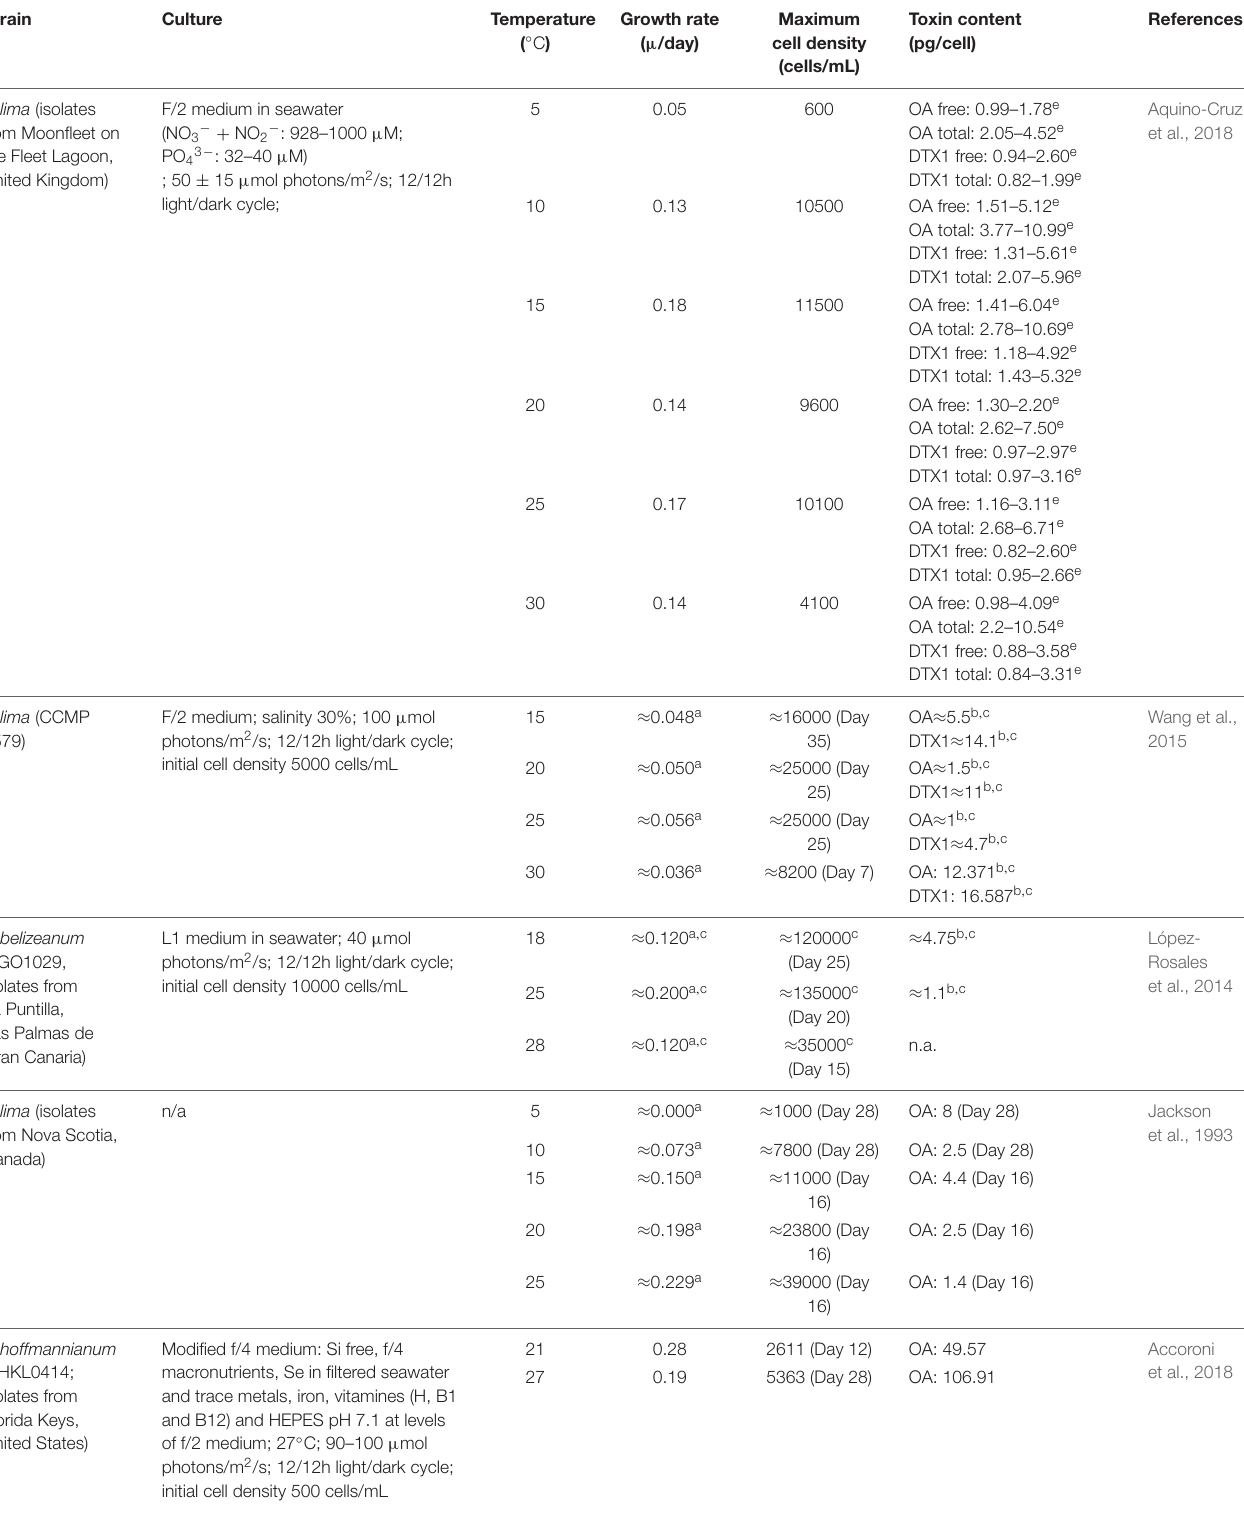
TABLE 5 | Effect of temperature on the growth and toxin content of Prorocentrum